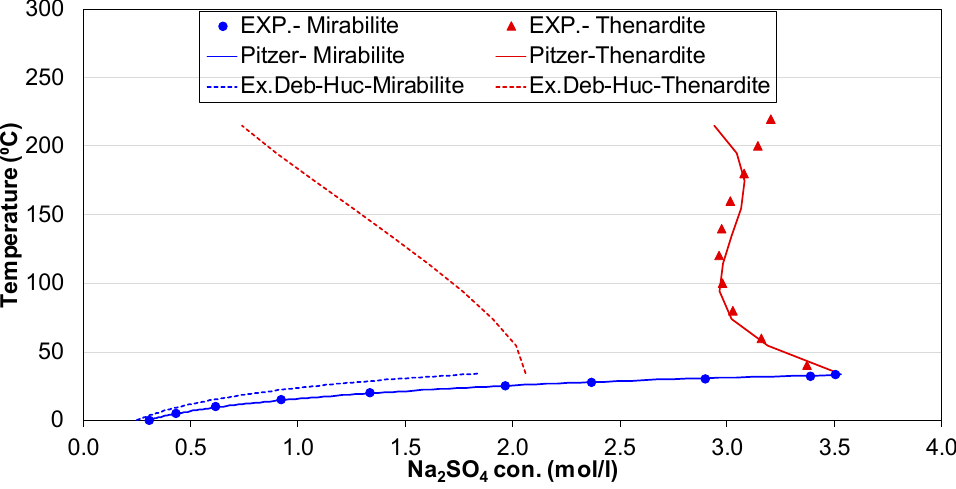
Figure 2. Influence of activity coefficient on Na 2 SO 4 solubility [30].